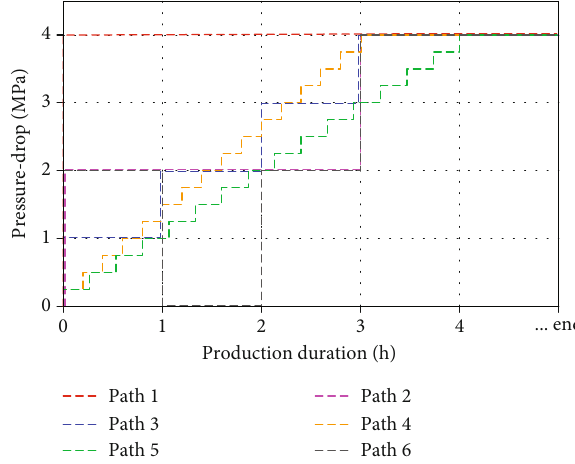
Figure 5: Pressure-drop controlling schedules for numerical